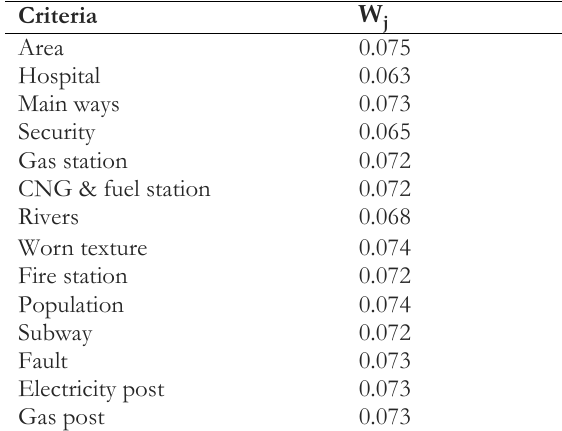
Table 4. Weight criteria.